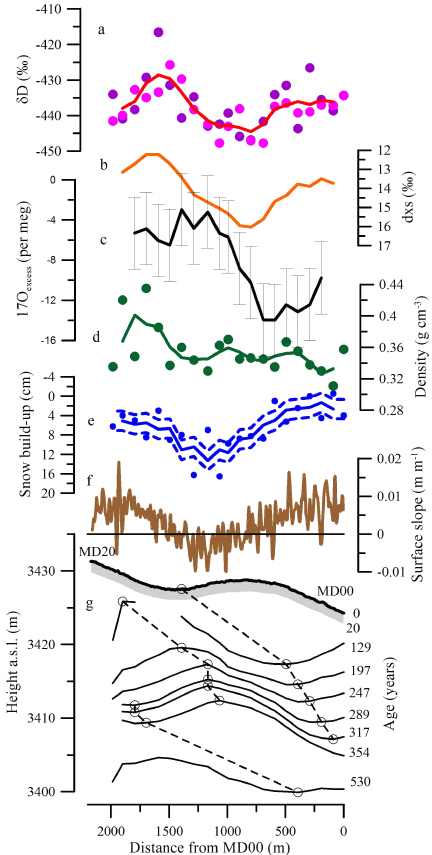
Figure 3. The results of the glaciological, GPR and geodetic survey in the Vostok megadune area. (a–c) Isotopic content of the surface (1.5m) layer of the snow thickness: (a) δD , (b) dxs and (c) 17 O- excess. For δD the points show the individual samples and the red line is the average of the 58 and 59 RAE samples. For dxs only the average is shown. Note that the dxs axis is reversed. For 17 O- excess we showed the 5-point running means with the error bars ( ± 1 σ , where σ is the error of the average of five individual values). (d) Surface (20cm) snow density, individual values (points) and 3- point running mean (line). (e) Mean snow build-up in 2013-2014, individual values (points) and 3-point running mean. Dashed lines show the confidence interval ( ± 1 σ ) of 2-year average accumulation value as deduced from Vostok stake network. Note that the y axis is reversed. (f) Surface slope calculated over 20m intervals of the ice sheet surface. Negative values mean that the local slope is the op- posite of the general slope in this region (from south-west to north- east). (g) The elevation of the ice sheet surface and seven internal reflection horizons (IRH) above sea level defined by the geodetic measurements and GPR survey. The grey shading depicts the snow layer (1.5m) in which the snow isotopic content was measured. The dashed lines connect the fold hinges used to calculate the dune drift velocity. The values to the right are the estimated ages of each IRH relative to January 2015. The profile is spread from the south-west (left part of the figure) to the north-east (right part), see Figure 1. The individual values shown in Fig. 3 can be found in Table 1.